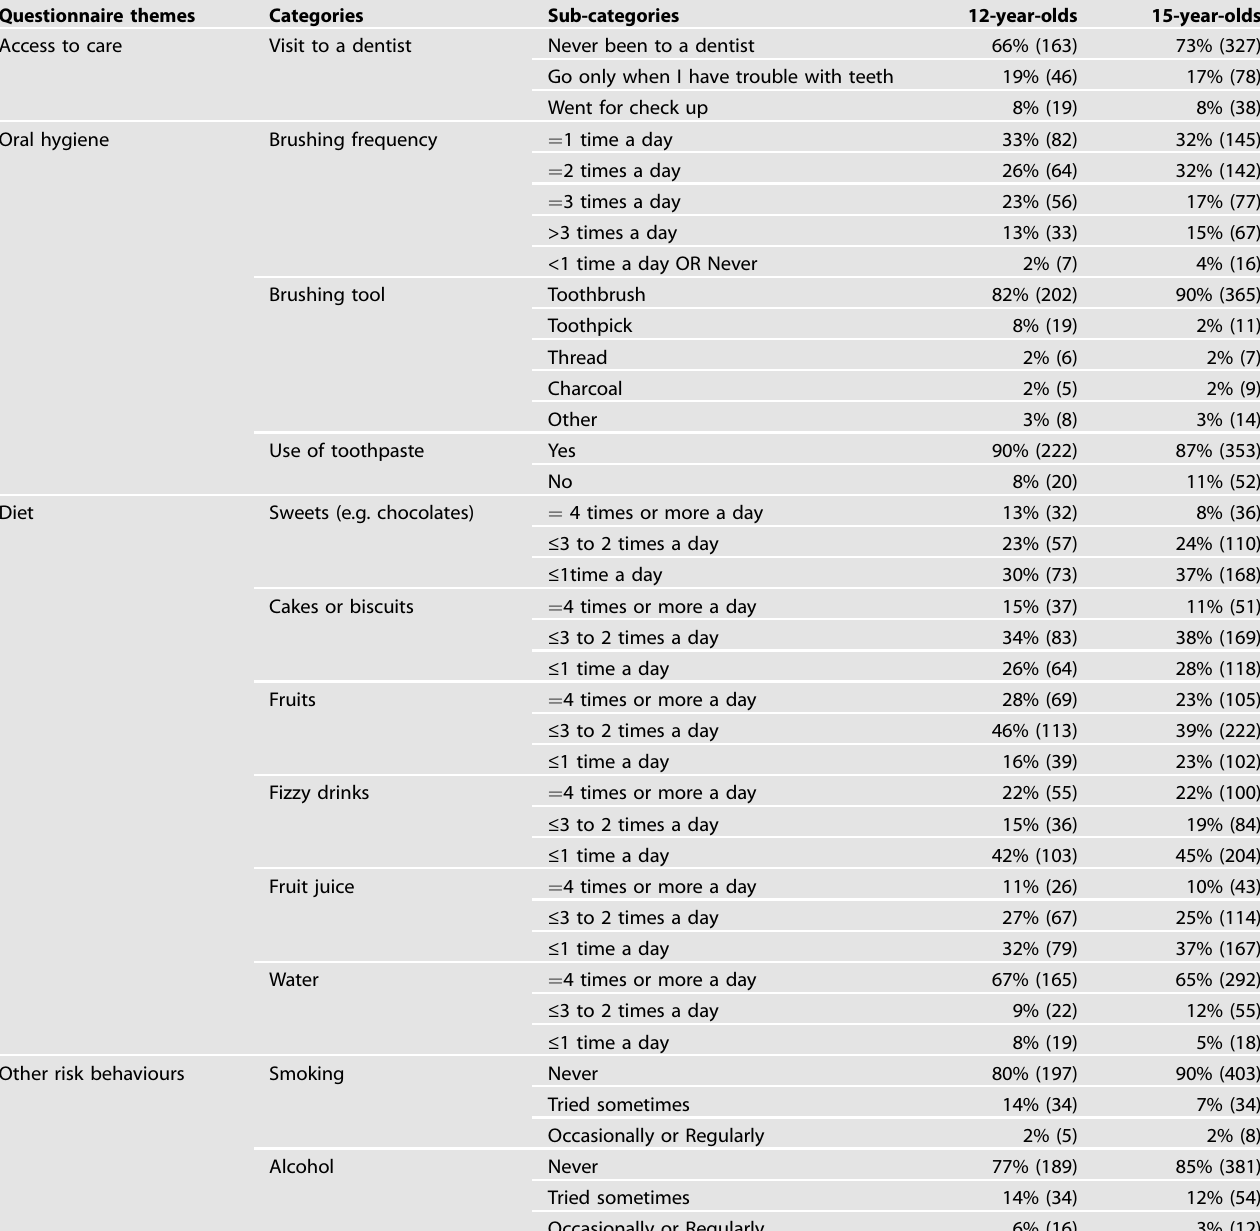
Table 5. Self-reported oral health and oral health behaviours of school children in SL. Questionnaire